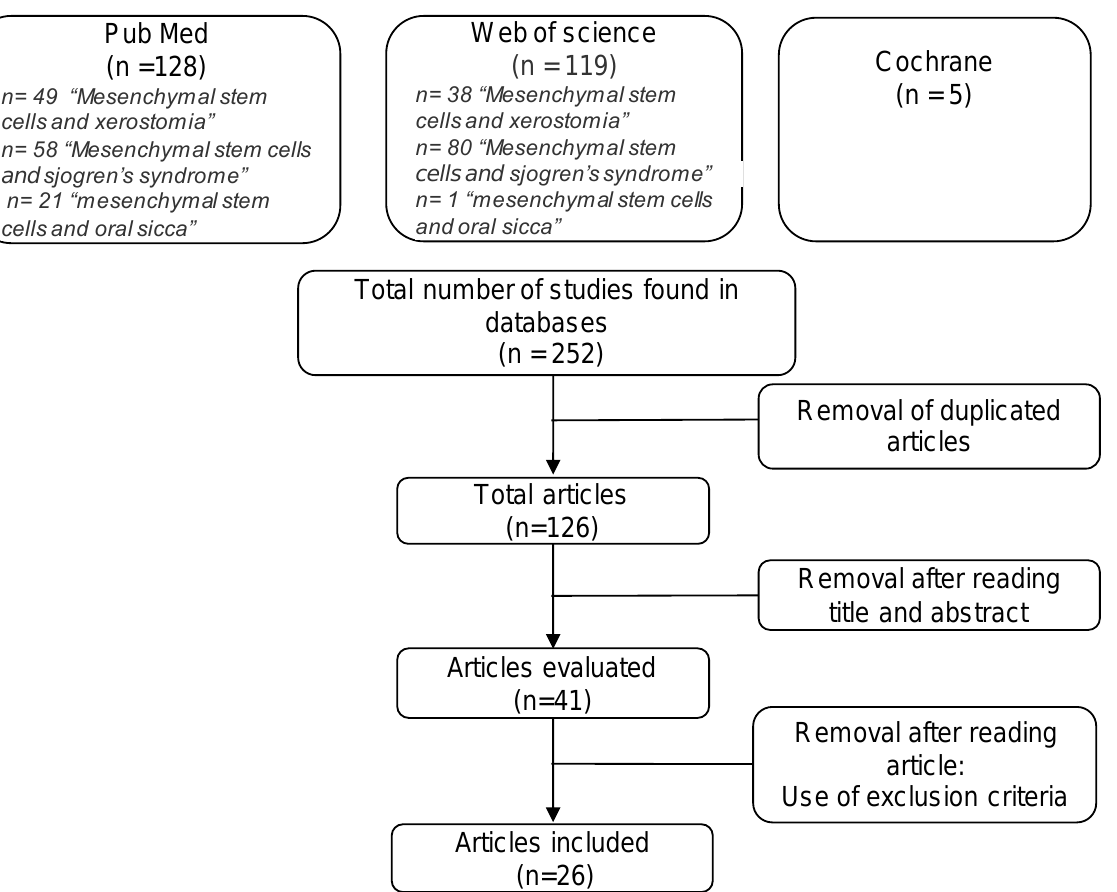
Figure 1. Selection flowchart for articles referring to mesenchymal stem cells in Sjögren’s syndrome.